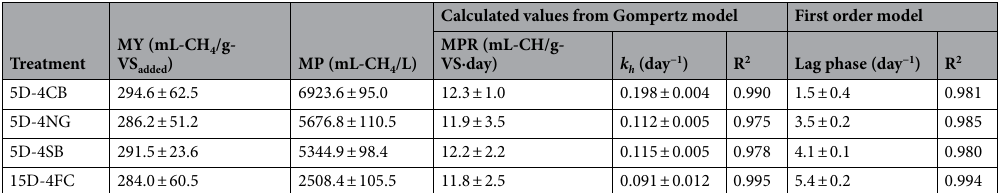
Table 7. Methane production of lignocellulosic material prehydrolyzed by cellulolytic consortium KKU-MC1. 5D substrate pretreated with KKU-MC1 for 5 days, 15D substrate pretreated with KKU-MC1 for 15 days, 4 at 4% initial volatile solid concentration